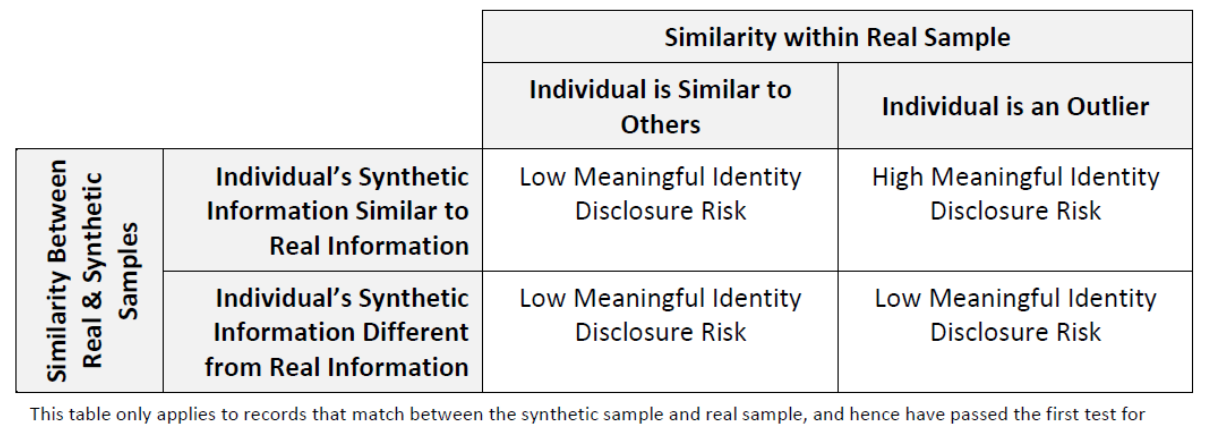
Figure 2. The relationship between a real observation to the rest of the data in the real sample and to the synthetic observation, which can be used to determine the likelihood of meaningful identity